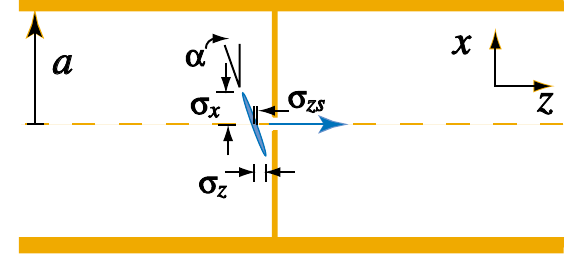
FIG. 1. (Color) A sketch in the x - z plane of the beam and the foil with its slot. The beam pipe is round but the slot is flat, with half-width (cid:1) x . The beam is tilted in x - z by angle (cid:6) ( (cid:6) 1 ), with the longitudinal slice rms length, (cid:3) (cid:1) (cid:3) (cid:1) (cid:3) (cid:3) , (cid:3) x z y zs